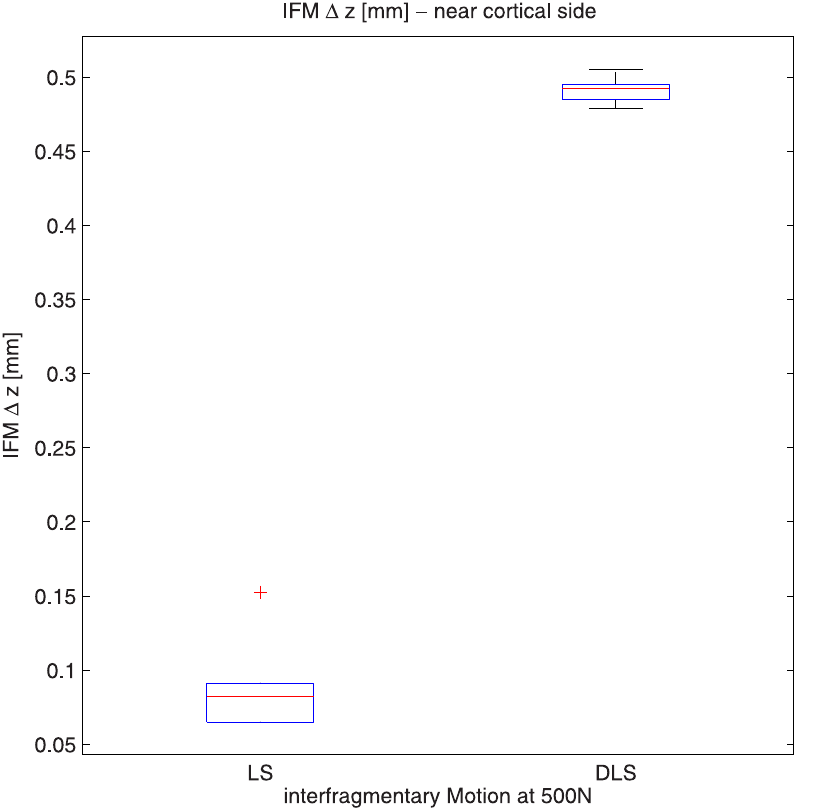
Figure 8. With application of a 500 N axial load, the interfragmentary motion at the near cortex was significantly higher in the DLS group (0.49 mm; SD ± 0,008 mm) compared to the LS group (0.089 mm; SD ± 0,03